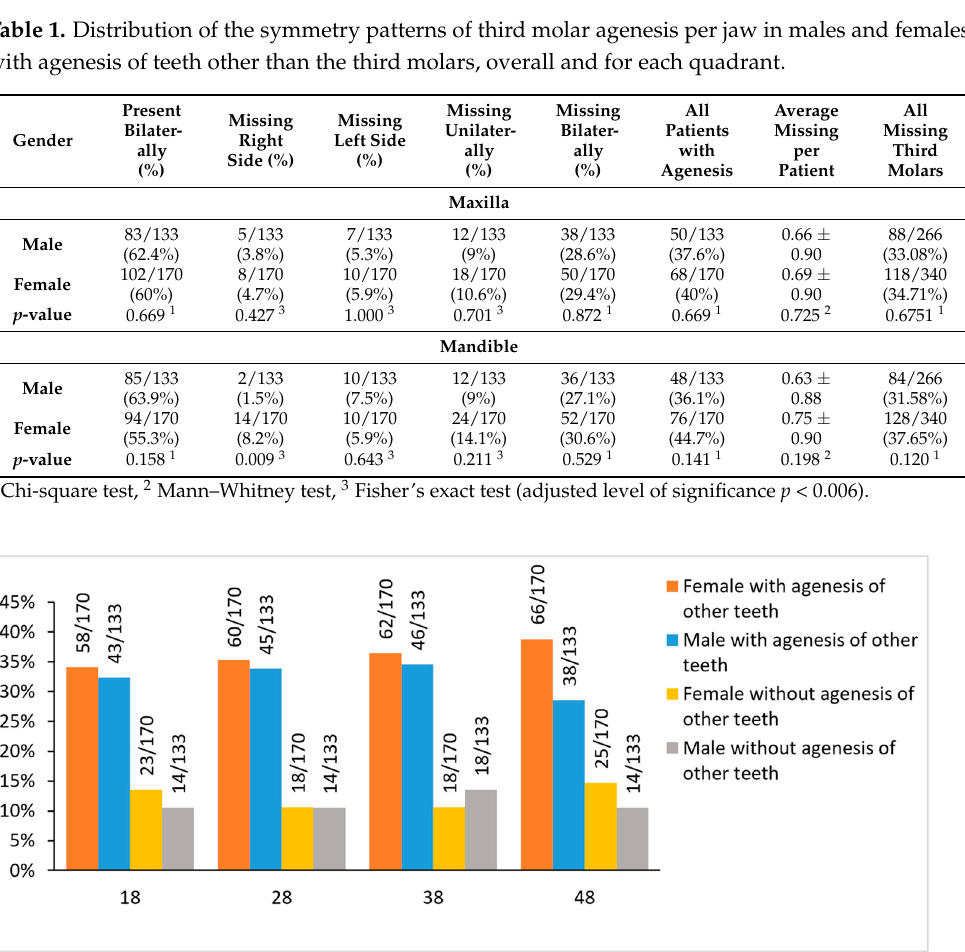
Table 1. Distribution of the symmetry patterns of third molar agenesis per jaw in males and females with agenesis of teeth other than the third molars, overall and for each quadrant.